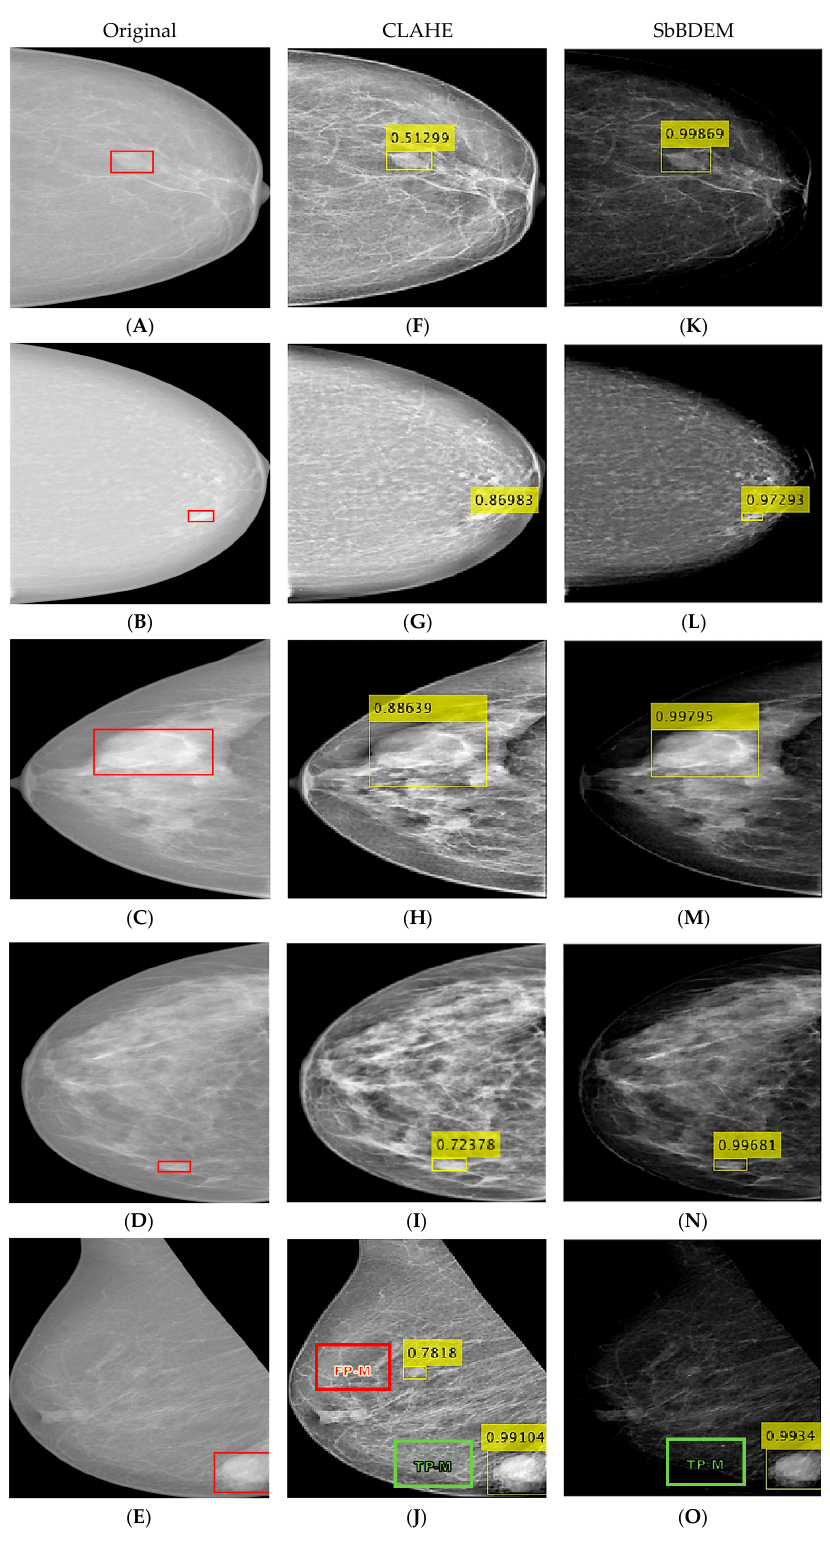
Figure 6. Result of Mass Detection for comparison. Rows 1 and 2: non-dense breasts. Rows 3 and 4: dense breasts. Row 5: Example of image with True Positive mass ( TP-M ) and False Positive mass ( FP-M ) detections. Yellow boxes indicate bounding boxes with a confidence score for mass detec- tion. ( A – E ): Original images. ( F – J ): CLAHE-enhanced images. ( K – O ): proposed SbBDEM images. Other than that, Row 5 of Figure 6E,J,O demonstrates an example of True-Positive Mass (TP) (TP-M) and False-Positive Mass (FP) (FP-M) detections during the mass detec- tion stage. Further pixel analysis based on edge detection emulated by the network’s con- volutional process is extracted using an 8-by-8 grid window size on the edge of expected mass FP-M corresponding to Figure 7A–B, and mass TP-M in Figure 7C,D.